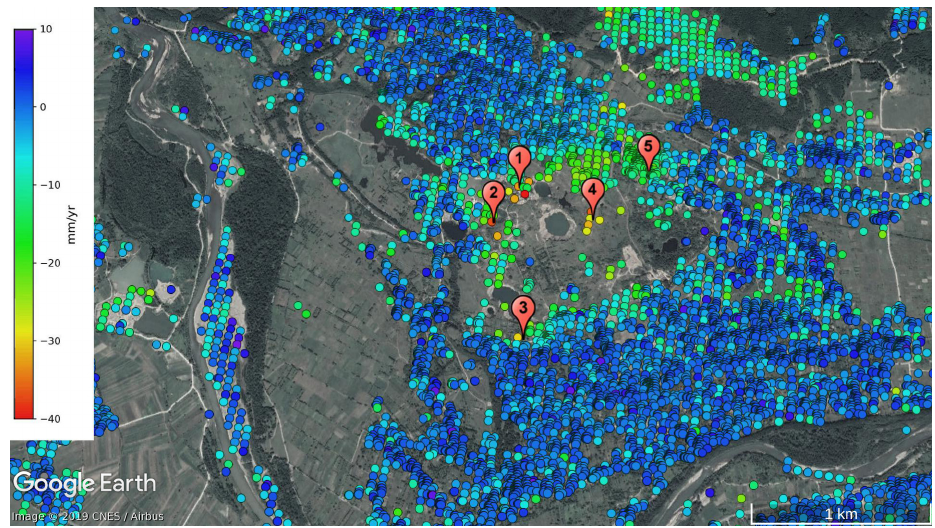
Figure 6. Linearly estimated LOS deformation rate in millimeters per year calculated from Sentinel-1 descending pass data for the investi- gated area. Contains modified Copernicus Sentinel data (2014–2019), background ©